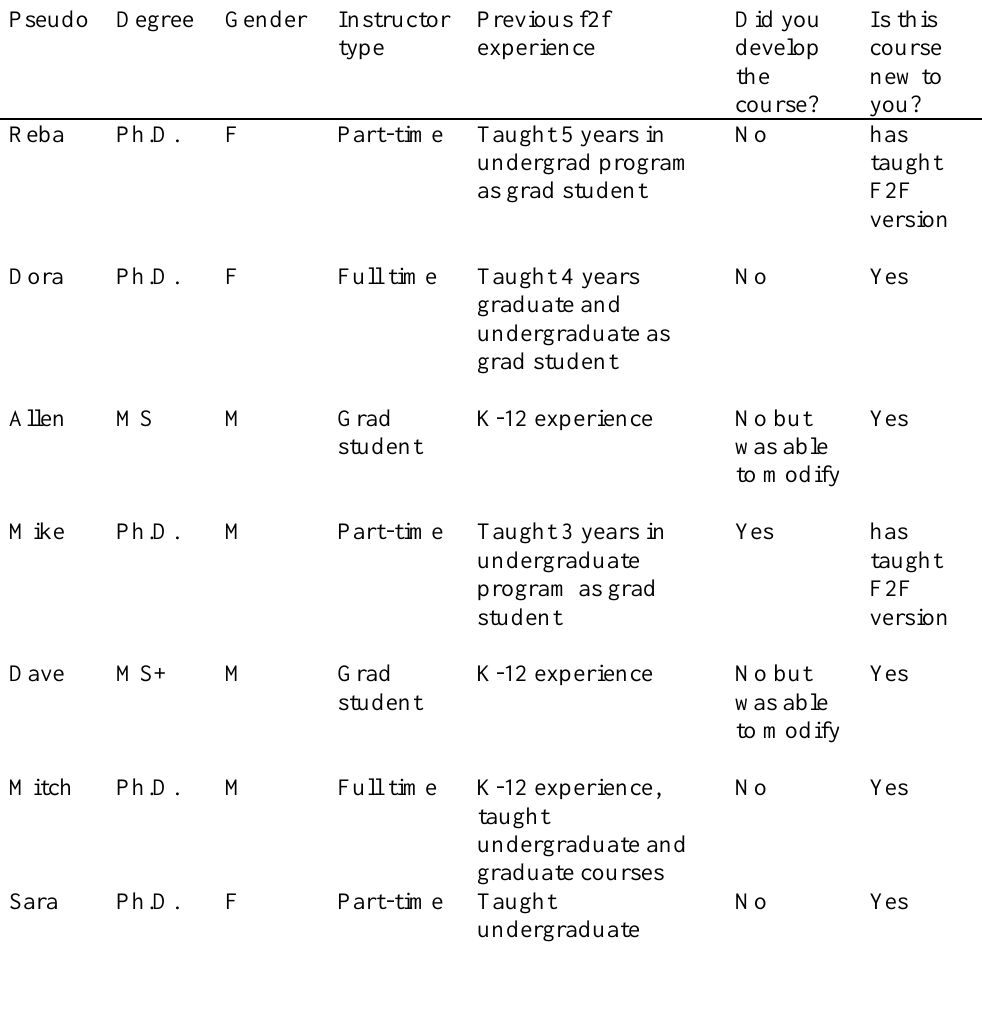
Table 1 Participants’ Backgrounds, Previous Face-to-Face (F2F) Teaching Experiences, and Course